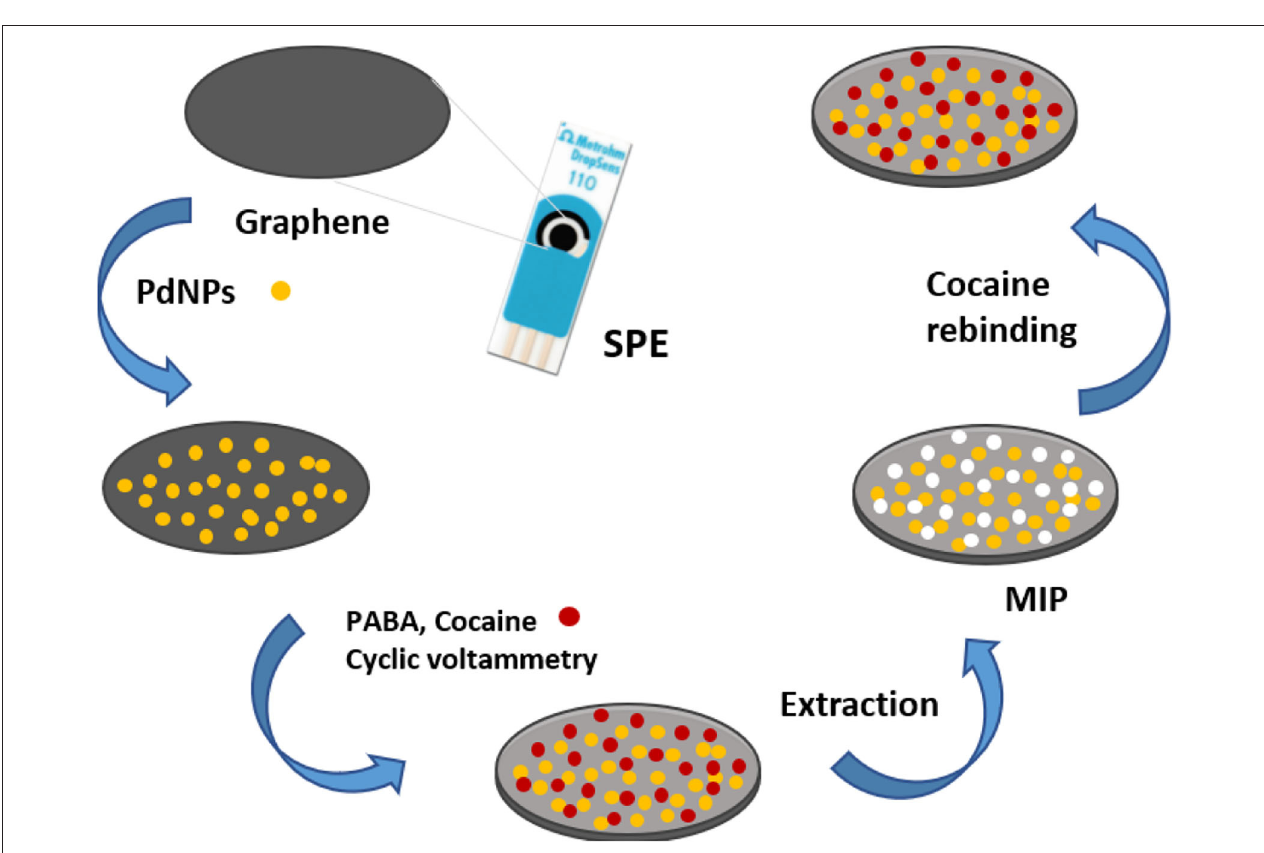
FIGURE 5 | MIP-based sensor fabrication for the detection of cocaine. Reproduced from Florea et al. (2019a) with permission from the Royal Society of Chemistry.